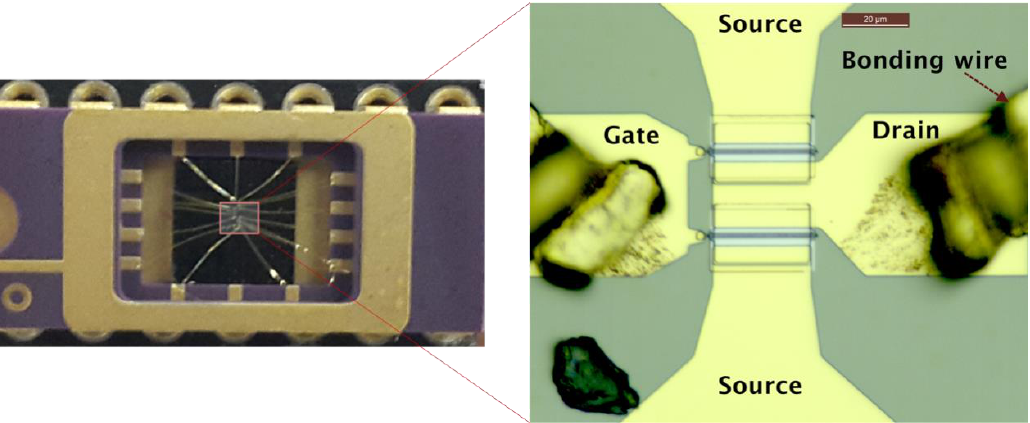
Figure 3. Left: The device under study, framed in a red rectangle for ease of viewing, glued and mounted on a DIP14 and wire-bounded to it. Right: Detailed view of the Π -gate transistor.